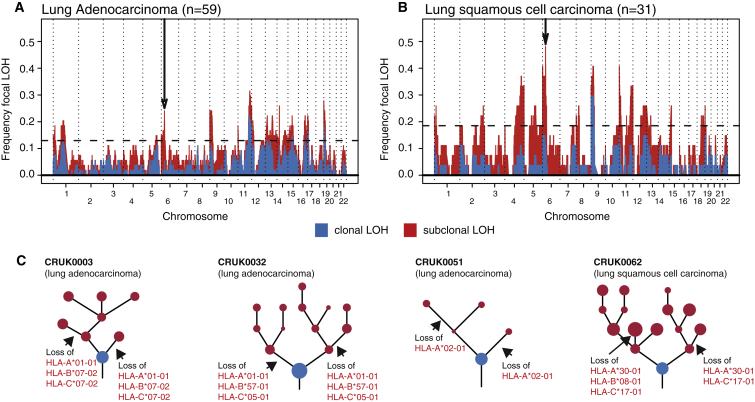
HLA LOH Reflects Selection in NSCLC(A and B) Frequency of focal LOH in lung adenocarcinoma (A) and lung squamous cell carcinoma (B). Focal LOH is defined as <75% of a chromosome arm. Arrow indicates location of HLA locus. Horizontal dashed line depicts significant focal LOH at p = 0.05, using simulations. Clonal LOH is shown in blue, with subclonal LOH shown in red. Chromosome arm LOH and focal subclonal LOH is shown in Figure S3.(C) Parallel evolution of HLA LOH, with allele-specific HLA loss shown on phylogenetic trees.See also Figure S3.